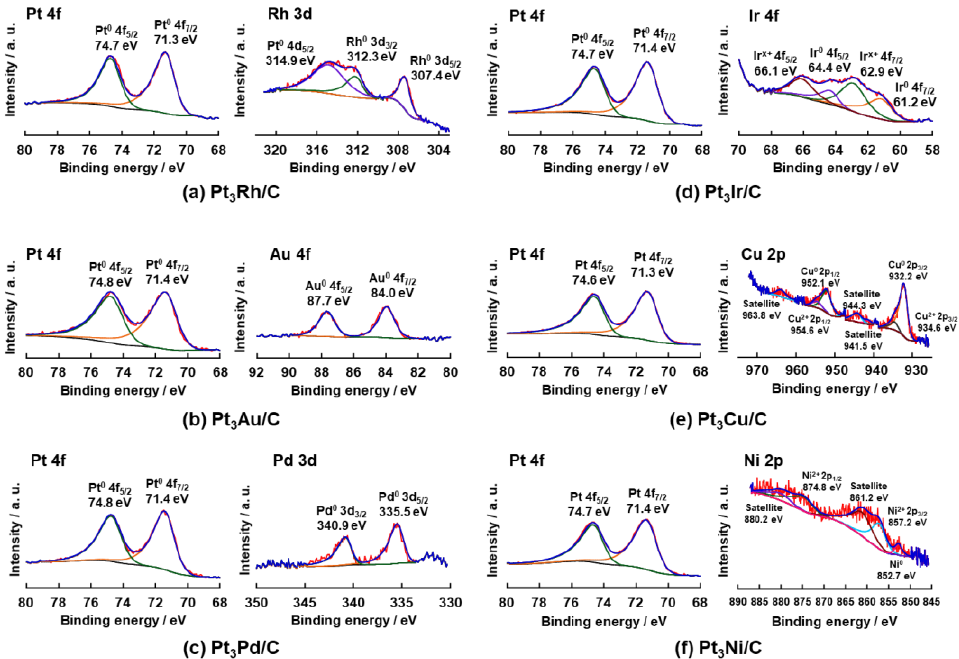
Figure 2. Pt4f and Rh3d, Au4f, Pd3d, Ir4f, Cu2p or Ni2p core level spectra for ( a ) Pt 3 Rh/C, ( b ) Pt 3 Au/C, ( c ) Pt 3 Pd/C, ( d ) Pt 3 Ir/C, ( e ) Pt 3 Cu/C and ( f ) Pt 3 Ni/C catalysts. Table 2. Surface composition, bulk composition, metal loading mass and mean crystallite size for Pt 3 M/C (M = Rh, Au, Pd, Ir, Cu and Ni) catalysts as prepared and after the linear sweep voltammetry measurement for electrochemical toluene (TL) hydrogenation. Surface Composition (1) Bulk Composition